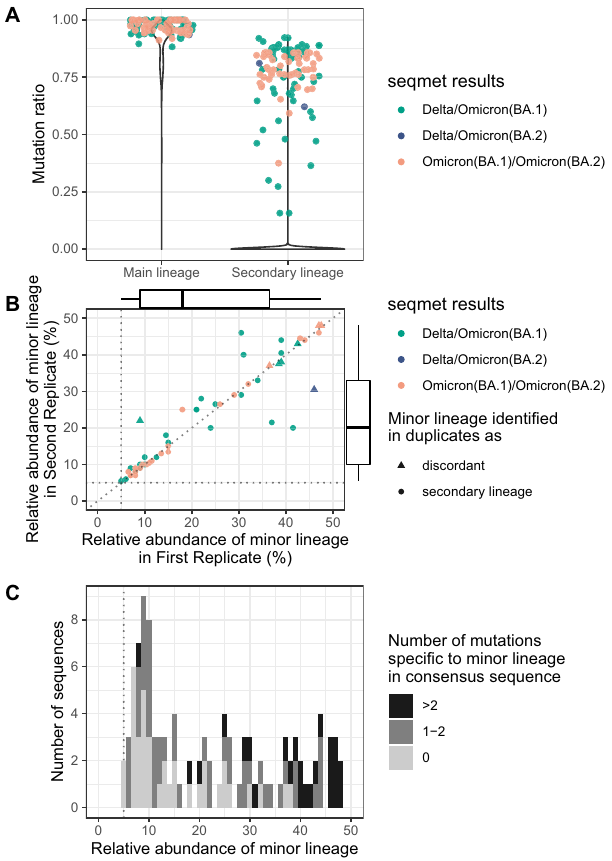
Fig.3|Naturalco-infectionsdetectedbetweenDecember6,2021andFebruary 27, 2022. A Violin plot of main and secondary virus mutation ratios for the 21,387 samples, including 61 samples sequenced in duplicate. The lineage ratio is consideredtobe0incaseswherelessthan6mutationswerefoundorcoveredwith at least 100x for any lineage. Positive secondary virus mutation ratios in indepen- dent duplicates with concordant virus identi fi cation were considered as potential co-infectionsanddepictedwithdots( n =53).Colorsindicatelineages:co-infections between Delta/BA.1 are in green, Delta/BA.2 in dark blue, and BA.1/BA.2 in salmon. B Correlationbetweentherelativeabundanceoftheminorlineagein n =53natural co-infections sequenced in duplicate. Relative abundance is measured by the median of allele frequencies speci fi c to the minor lineage. Distributions of relative abundance in fi rst and second replicates are depicted as marginal boxplots. Box- plot represents median and IQR, with upper and lower whiskers extending to the largest and smallest value, respectively. Dotted lines are drawn at 5%, which is the threshold used to call a mutation in the variant calling step of seqmet. Colors indicate lineage as in panel A . Shapes indicate whether the minor lineage is iden- ti fi ed as the secondary or main lineage in duplicate or a potential discordance between duplicates. C Number of chimeric sequences detected among the 53 naturalco-infectionssequencedinduplicate,dependingontherelativeabundance of the minor lineage. Chimeric sequences were de fi ned by sequences bearing speci fi c mutations of two lineages, with a gradient of color depending on the number of speci fi c mutations from the less abundant lineage: 0 mutation (light grey), 1 – 2 speci fi c mutations (medium grey), >2 speci fi c mutations (dark